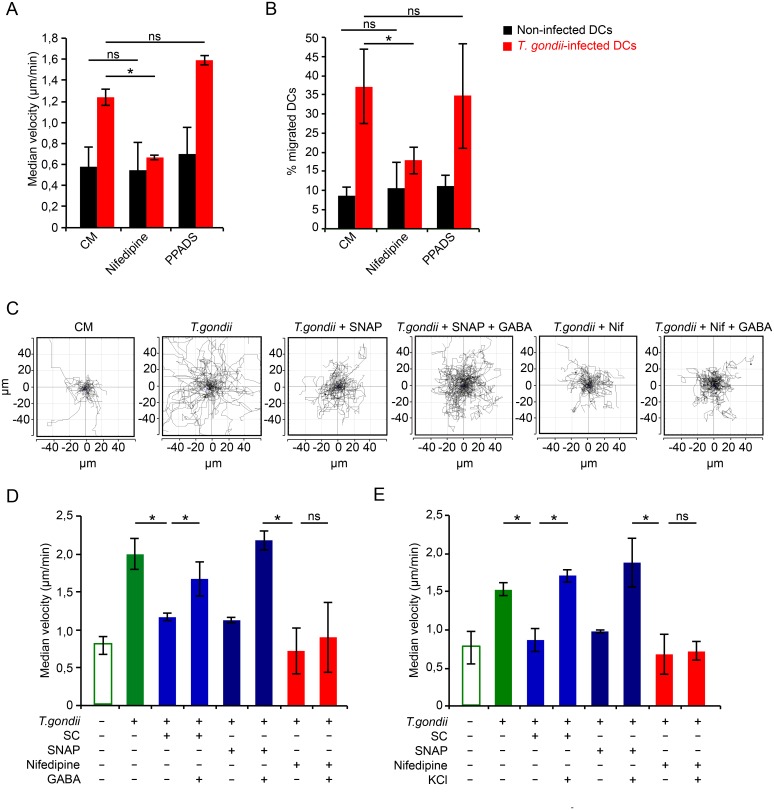
VDCC blockade abolishes GABA-mediated hypermigration of infected DCs that is not rescued by exogenous GABA or membrane depolarization.(A) Motility analysis of DCs incubated with PRU tachyzoites for 3 h and treated for 1 h with nifedipine (10 μM) or PPADS (100 μM). Data represent median velocities ± SD of 3 independent experiments. Asterisks indicate significant differences (*: p < 0.001, ns: p ≥ 0.05, Pairwise Wilcoxon rank-sum test, Holm correction). (B) Transmigration frequency of DCs challenged with PRU tachyzoites for 5 h followed by treatment (1 h) with nifedipine (30 μM) or PPADS (100 μM). Data represent means ± SD of 3 independent experiments performed in duplicate. Asterisks indicate significant differences (*: p < 0.01, ns: p ≥ 0.05, One-way ANOVA, Tukey’s HSD test). (C) Representative motility plot analyses of DCs incubated with tachyzoites (PRU, MOI 3) for 2h with SNAP (50 μM), ± GABA (5 μM) or nifedipine (Nif, 10μM) ± GABA (5 μM). (D) Motility analysis of DCs incubated with PRU tachyzoites and treated for 2 h with SC (50 μM), SNAP (50 μM) or nifedipine (10 μM), ± GABA (5 μM). Data represent median velocities ± SD of 3 independent experiments. Asterisks indicate significant differences (*: p < 0.001, ns: p ≥ 0.05, Pairwise Wilcoxon rank-sum test, Holm correction). (E) Motility analysis of DCs incubated with PRU tachyzoites and treated as in (D) ± KCl (25 mM). Data represent median velocities ± SD of 3 independent experiments. Asterisks indicate significant differences (*: p < 0.001, ns: p ≥ 0.05, Pairwise Wilcoxon rank-sum test, Holm correction).